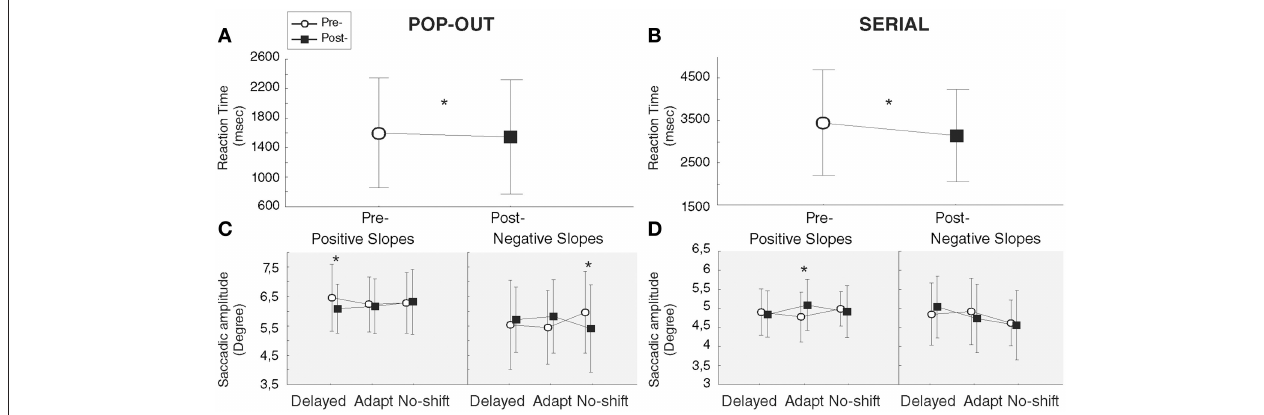
FIGURE 5 | Results of exploration tasks. Functional (A,B) and oculomotor ( C,D , gray background) measures of Pop-out (A,C) and Serial (B,D) exploration tasks. Bars represent the confident interval at 0.95. Stars represent significant differences between pre- and post-phases revealed by Post-hoc LSD Fisher